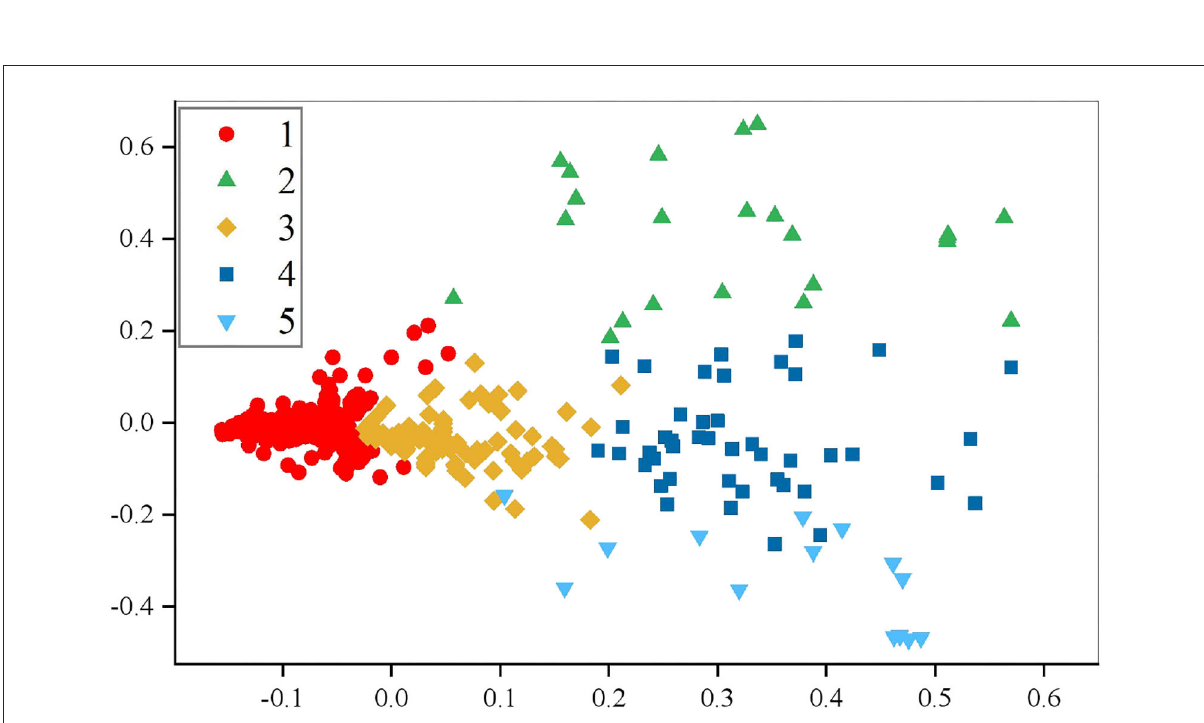
FIGURE6 The clustering effect of different